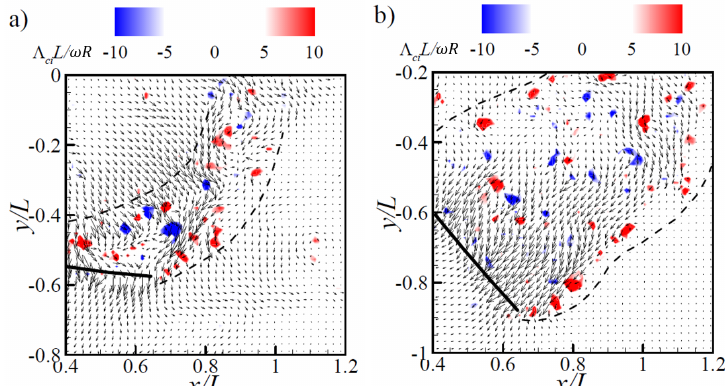
Figure 13. Instantaneous velocity fields superimposed with swirling strength (normalized by L / ω R ) at ω = 60 rpm around the: ( a ) thin plate; and ( b ) thick plate.